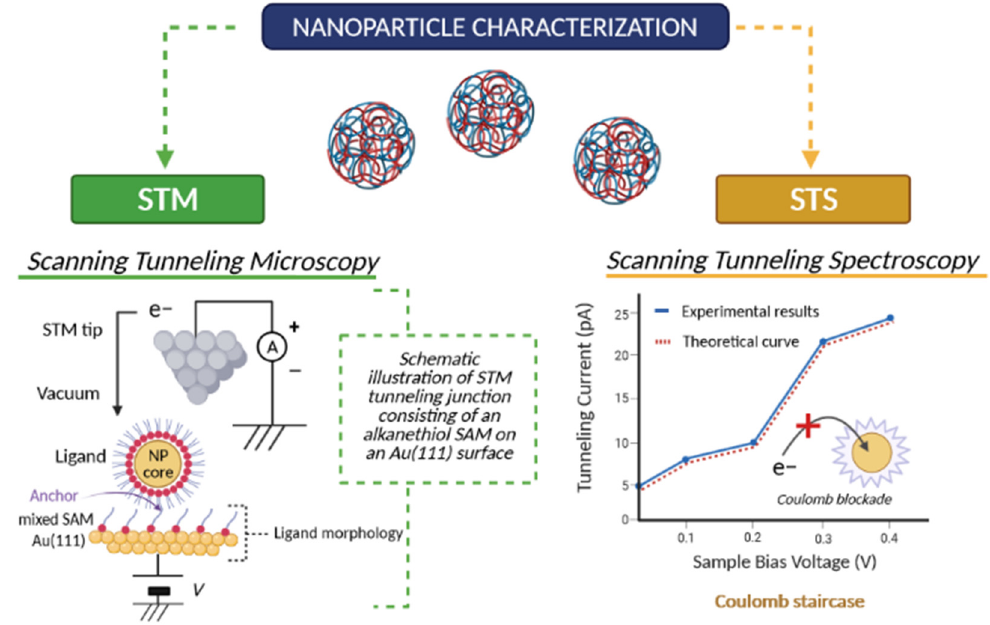
Figure 2. Schematic representation of Scanning Tunneling Microscopy (STM) and Scanning Tunneling Spectroscopy (STS) techniques for the characterization of nanoparticles [own drawing].